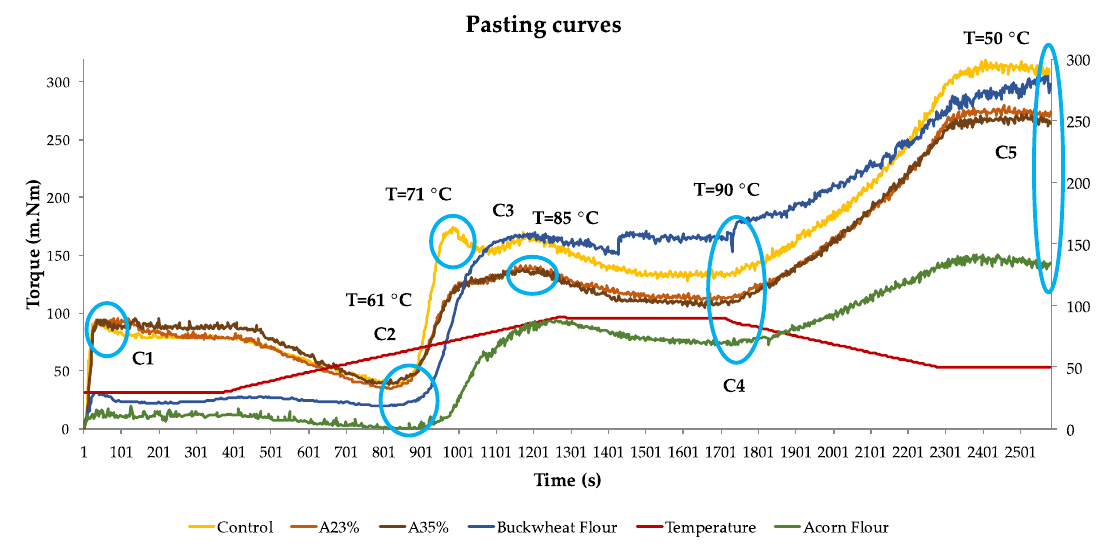
Figure 1. Pasting curves of the tested blend flours: control, A23% and A35%, and also buckwheat and acorn flour.